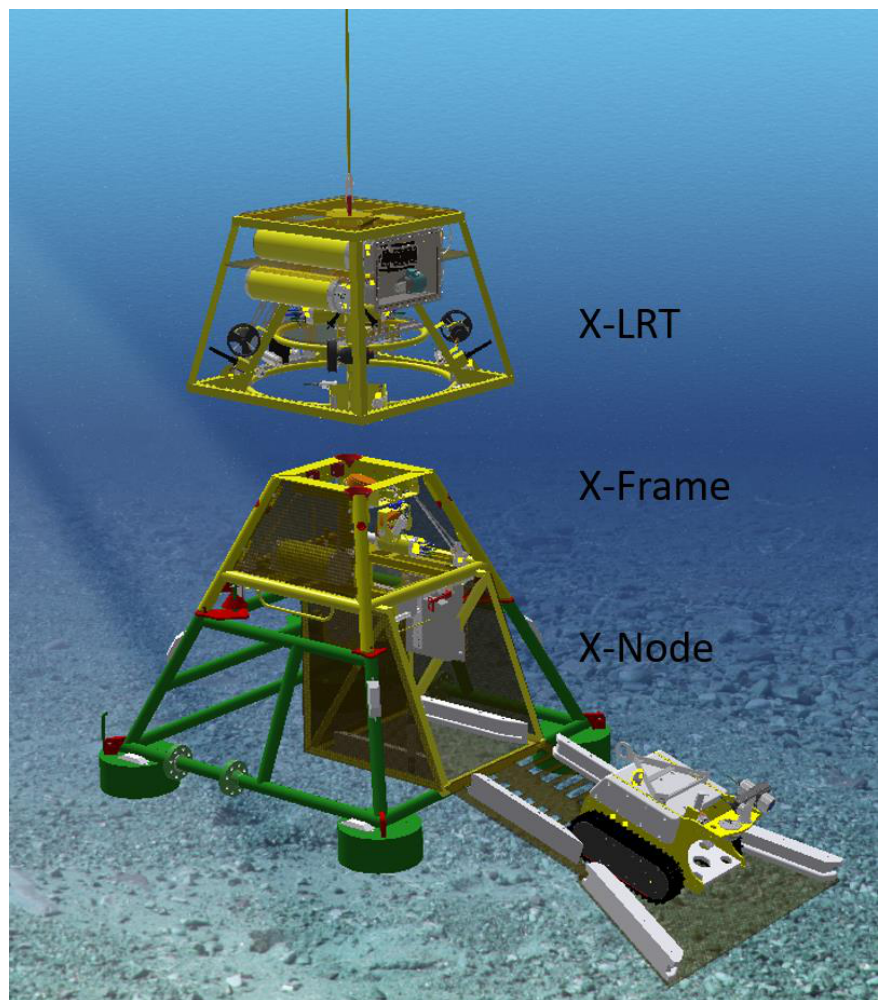
Figure 3. The bottom unit X-Net ® (Metas AS, Bergen, Norway) includes a bottom-based permanent cable connected docking station X-Node (green; see also Figure 2) and an instrumented exchangeable top unit (X-Frame; yellow) that can be launched and recovered with the Launch Recovery Tool (X-LRT). Note that the ARIM X-Frame includes the garage for the crawler (see Figure 2). This allows the user to operate and maintain the ARIM system without the assistance of expensive ROV vessel